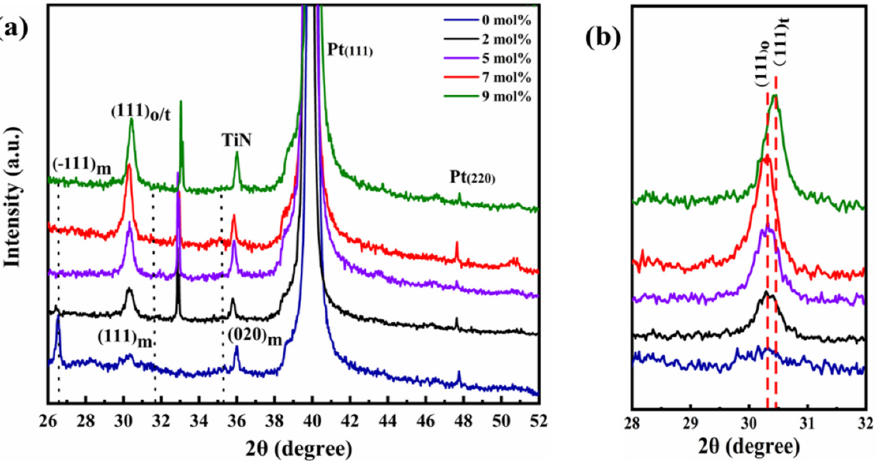
Figure 2. ( a ) GIXRD of different doping concentrations films; ( b ) zoomed-in view of the main peak from 28° to 32°.